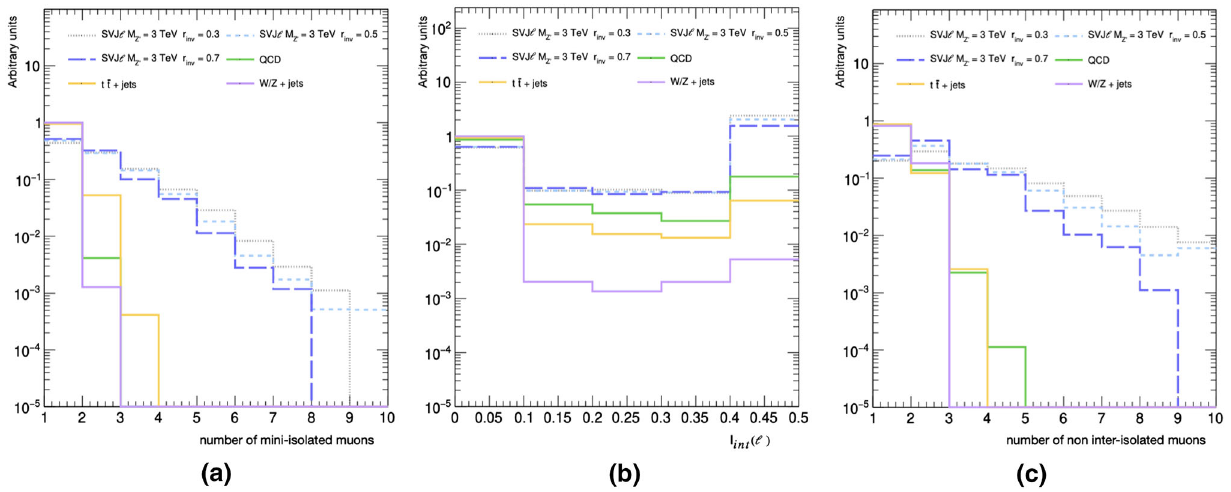
Fig. 2 a Multiplicity of mini-isolated muons. b Distribution of muons inter-isolation for R iso = 0 . 5. c Multiplicity of non inter-isolated muons.Inallthehistogramsthelastbinrepresentstheoverflow.Thesig-